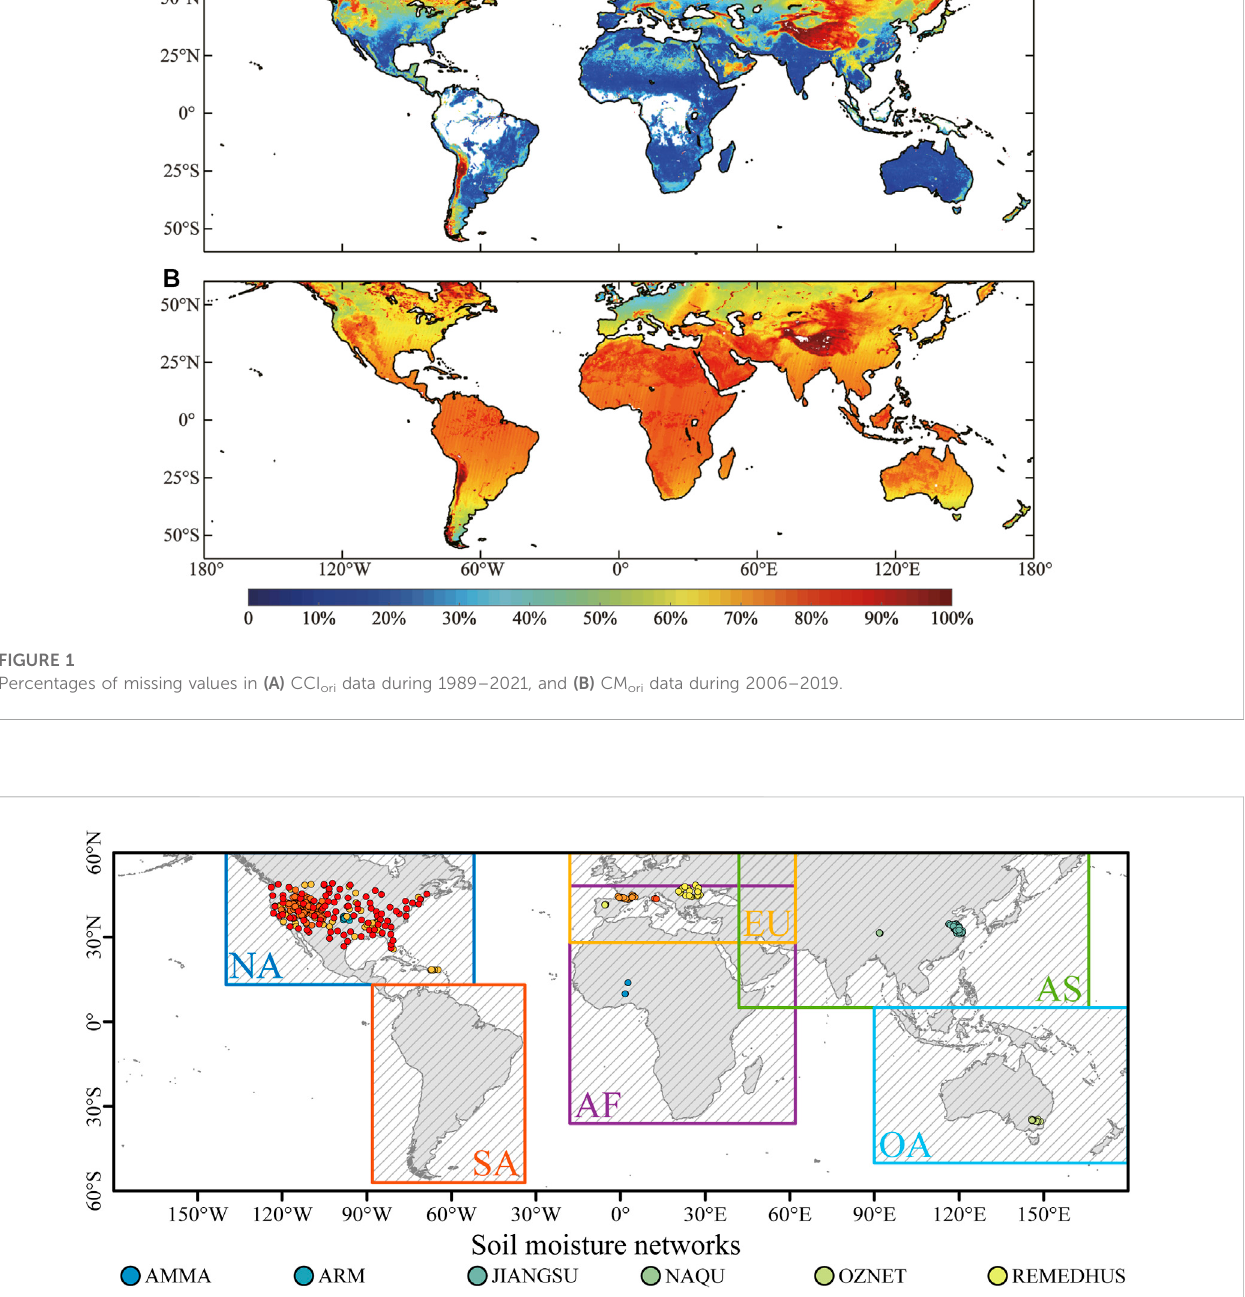
Figure 1. There are high percentages of missing data in highland mountains and mid-high latitudes, mainly due to frozen soil in winter.